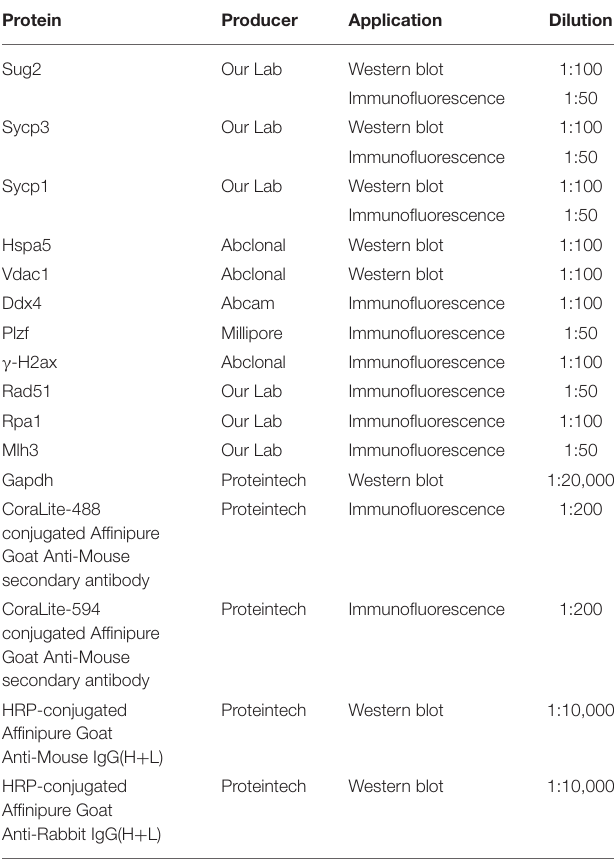
TABLE 2 | The antibody dilution ranges used in present research.